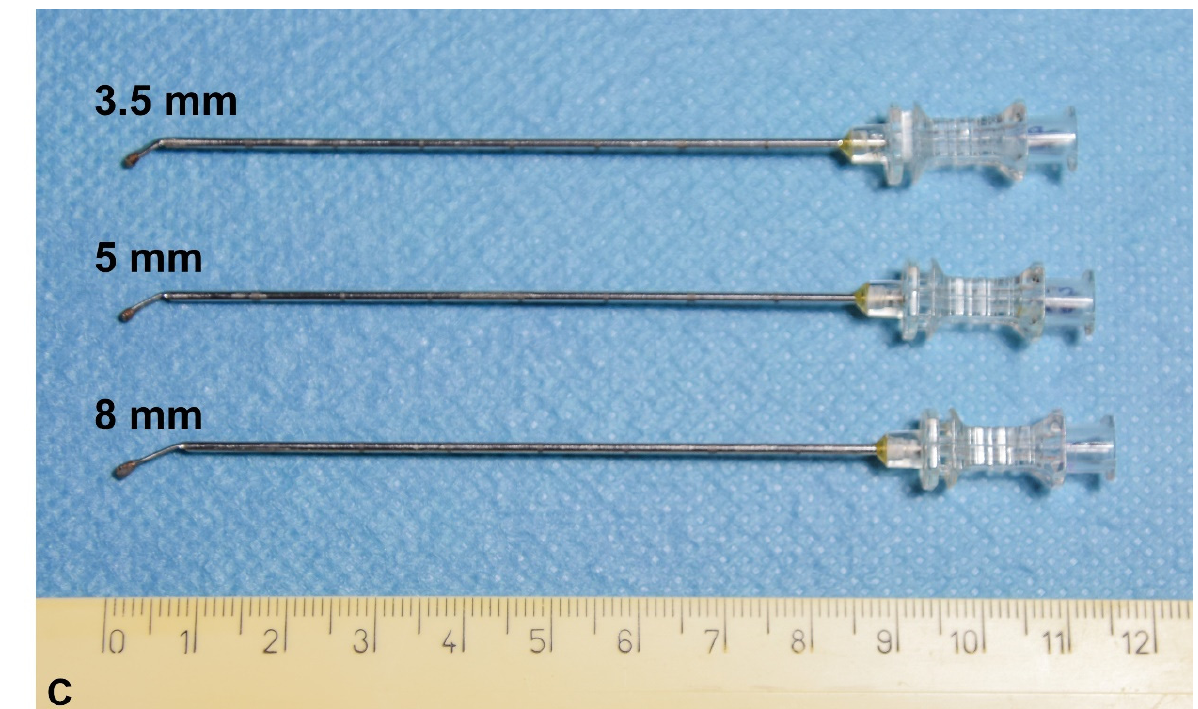
Figure 2. ( A ) Tools used for transcervical artificial insemination. From top to bottom: Bozeman forceps for cervical retraction; Cassou insemination gun for small ruminants (IMV technologies, France), inserted into the insemination catheter, composed of a stainless-steel tube (length: 28.5 cm, inner diameter: 3.5 mm); ( B ) detail of one end of the catheter fitted with a screw system to keep the Cassou gun secured; ( C ) detail of the other end composed of a modified epidural needle (Ø 14 G) with a 45° bent rounded atraumatic tip of different lengths: 3.5 mm, 5.0 mm or 8.0 mm.